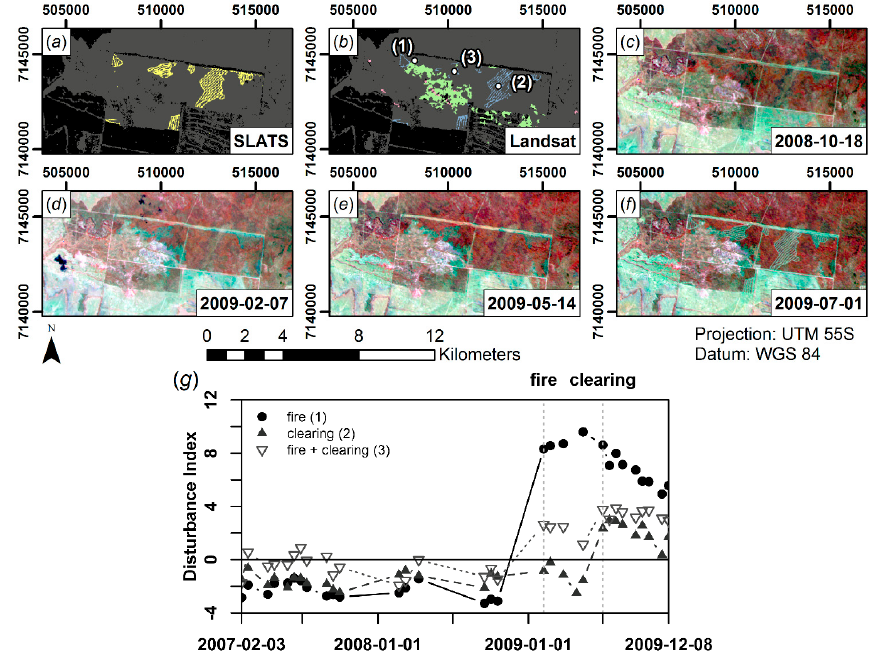
Figure 8. SLATS reference dataset, Landsat disturbance detection result for an area affected by regrowth, clearing and burning: ( a ) SLATS forest clearing (blue: 2008; yellow: 2009); ( b ) Landsat disturbance detection (see Figure A1 for the random color coding); ( c – f ) Landsat images depicting the clearing stages (RGB = NIR; SWIR1, red); and ( g ) temporal profiles of the Disturbance Index for two selected pixels marked in ( b ).